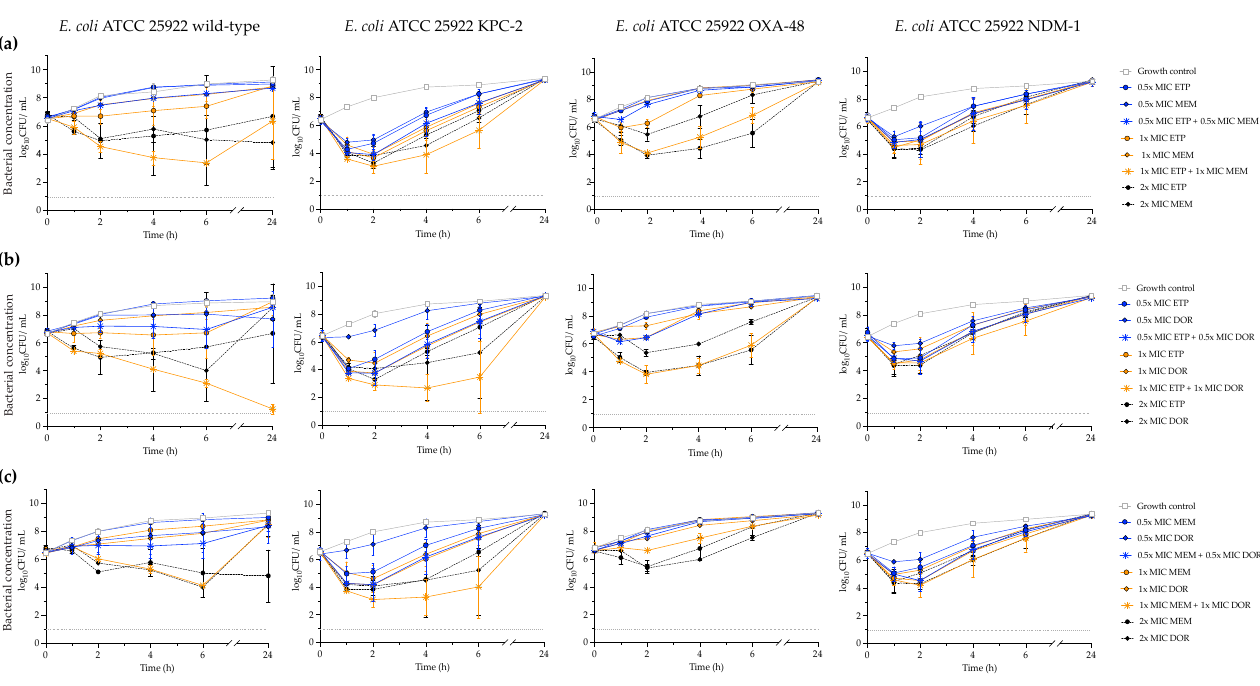
Figure 2. Mean bacterial concentrations during 24 h time-kill experiments with ertapenem, meropenem, and doripenem, alone and in two-drug combinations against E. coli ATCC 25922 wild-type and constructed carbapenemase-producing strains. ( a ) Ertapenem and meropenem; ( b ) Ertapenem and doripenem; ( c ) Meropenem and doripenem. The lower limit of detection (dotted line) was 1 log 10 CFU/mL. Abbreviations: ETP—ertapenem; MEM—meropenem; DOR—doripenem. To assess the possible emergence of resistance in the regrowing populations during time-kill experiments, 24 h samples were spread on plates containing ertapenem, mero- penem, or doripenem at 4 × and 8 × MIC. Resistance development was rare, and mutants were obtained only in five experiments at 4 × MIC (Supplementary Table S2). MIC in- creased in the isolated mutants ranging from 4- to 64-fold for ertapenem, 2- to 32-fold for meropenem, and 2- to 32-fold for doripenem. Four of the five mutants displayed a de- crease in growth rate ranging from 6 to 44% compared to the parental strain. Whole-ge- nome sequencing did not reveal any sequence variations previously known to be associ- ated with decreased carbapenem susceptibility, such as amino acid substitutions or gene amplifications of β -lactamase genes [3], or mutations in porin-encoding genes, penicillin- binding proteins, and other cell wall-associated genes (Supplementary Table S3).